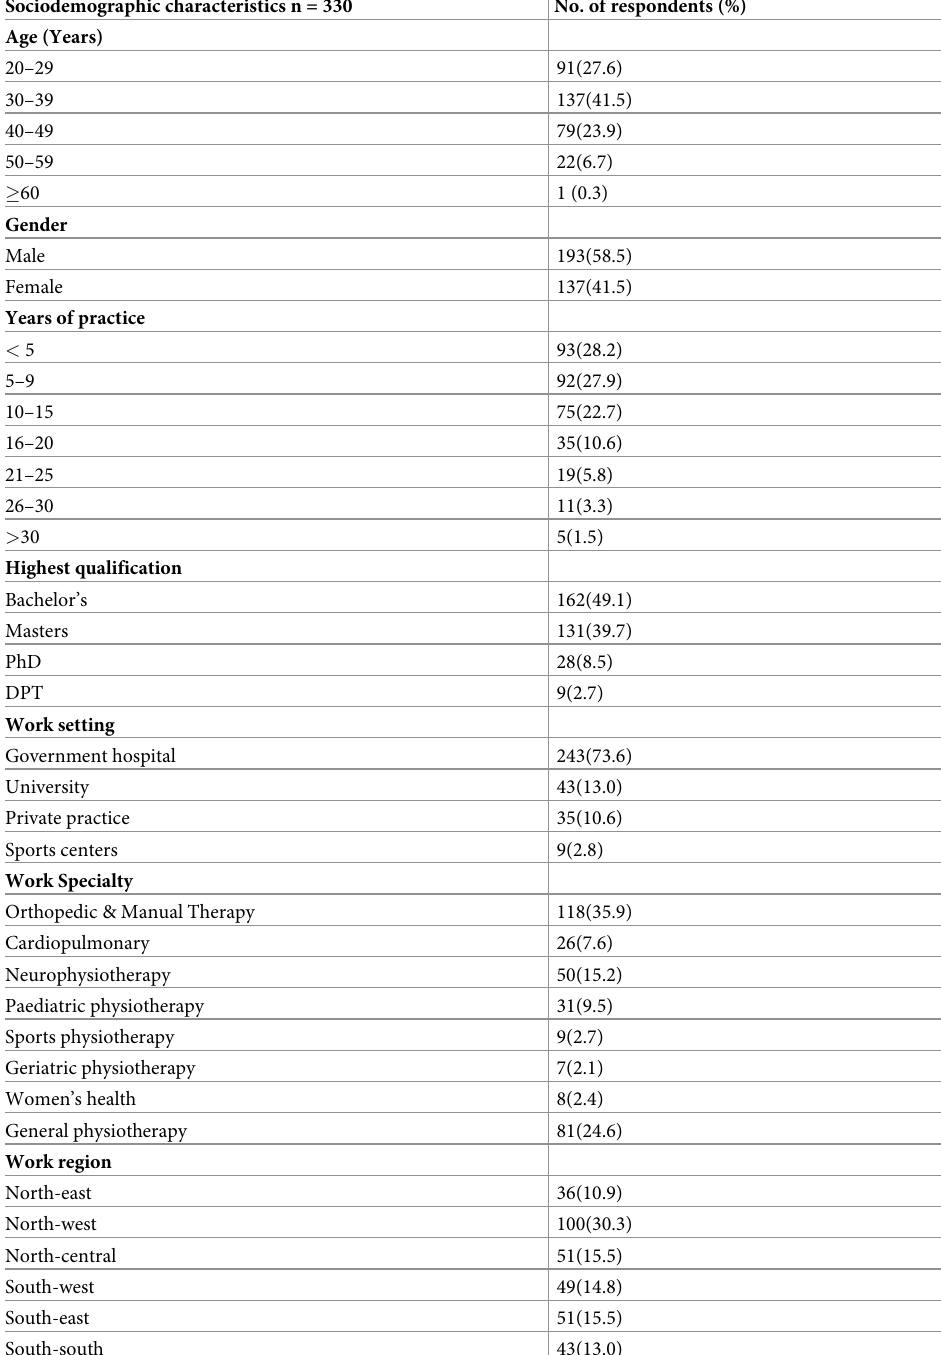
Table 1. Sociodemographic characteristics of